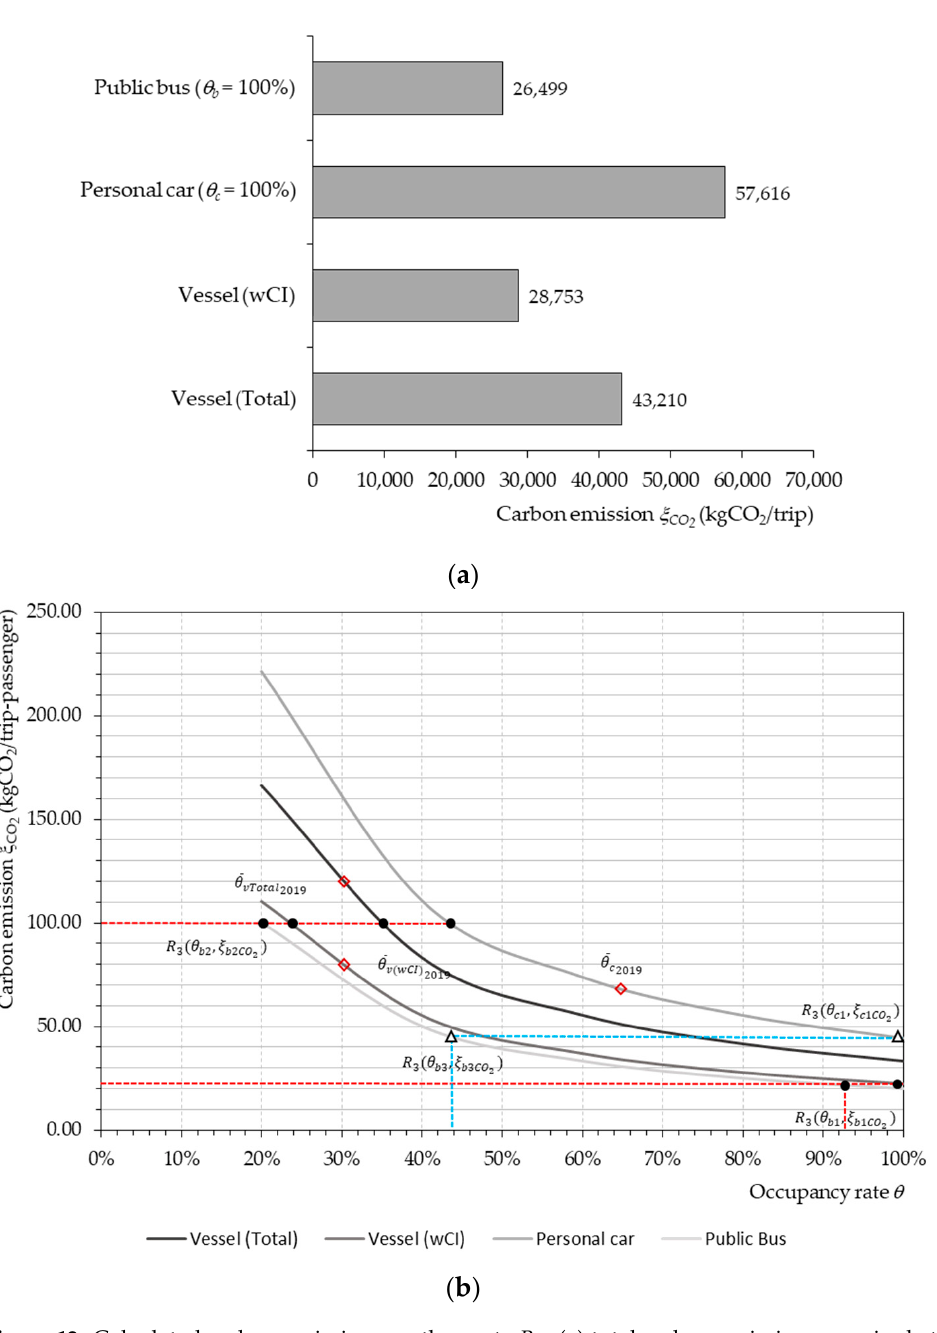
Figure 12. Calculated carbon emissions on the route R 3 : ( a ) total carbon emissions per single trip with respect to each transportation mode and based on the reference capacity of 1300 passengers; ( b ) comparison of carbon emissions with respect to the 𝜃 for each transportation mode choice.